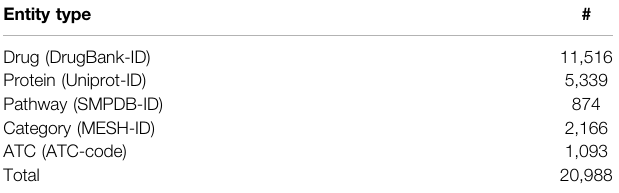
TABLE 1 | Statistics of heterogeneous pharmaceutical KG entities. TABLE 2 | Statistics of heterogeneous pharmaceutical KG edges for each relation type.